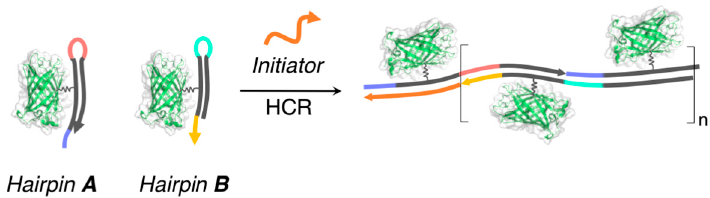
Figure 15. Schematic representation of the formation of linear supramolecular architectures that tethered the proteins by exploiting hybridization chain reaction (HCR) of nucleic acids. Adapted from [116]. Copyright 2018 American Chemical Society.